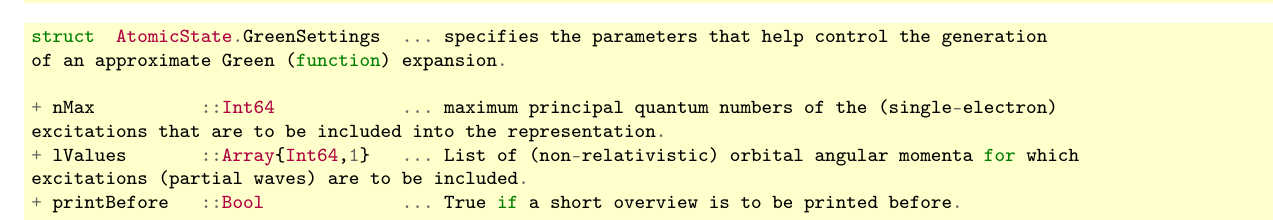
representation of an atom or ions, based on a set of reference configurations. One particular